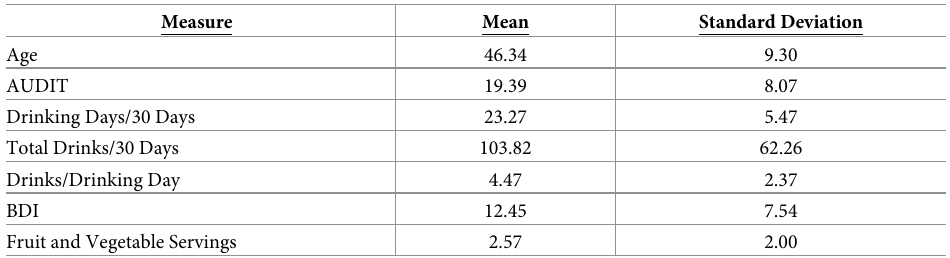
Table 1. Characteristics of sample at